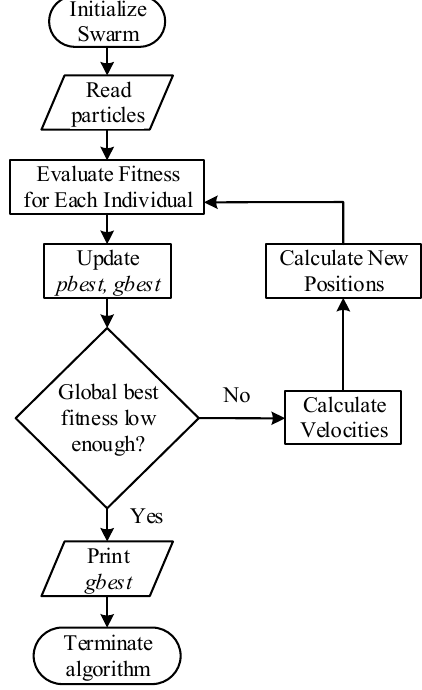
Figure 4. Flowchart of the particle swarm optimization (PSO) algorithm.